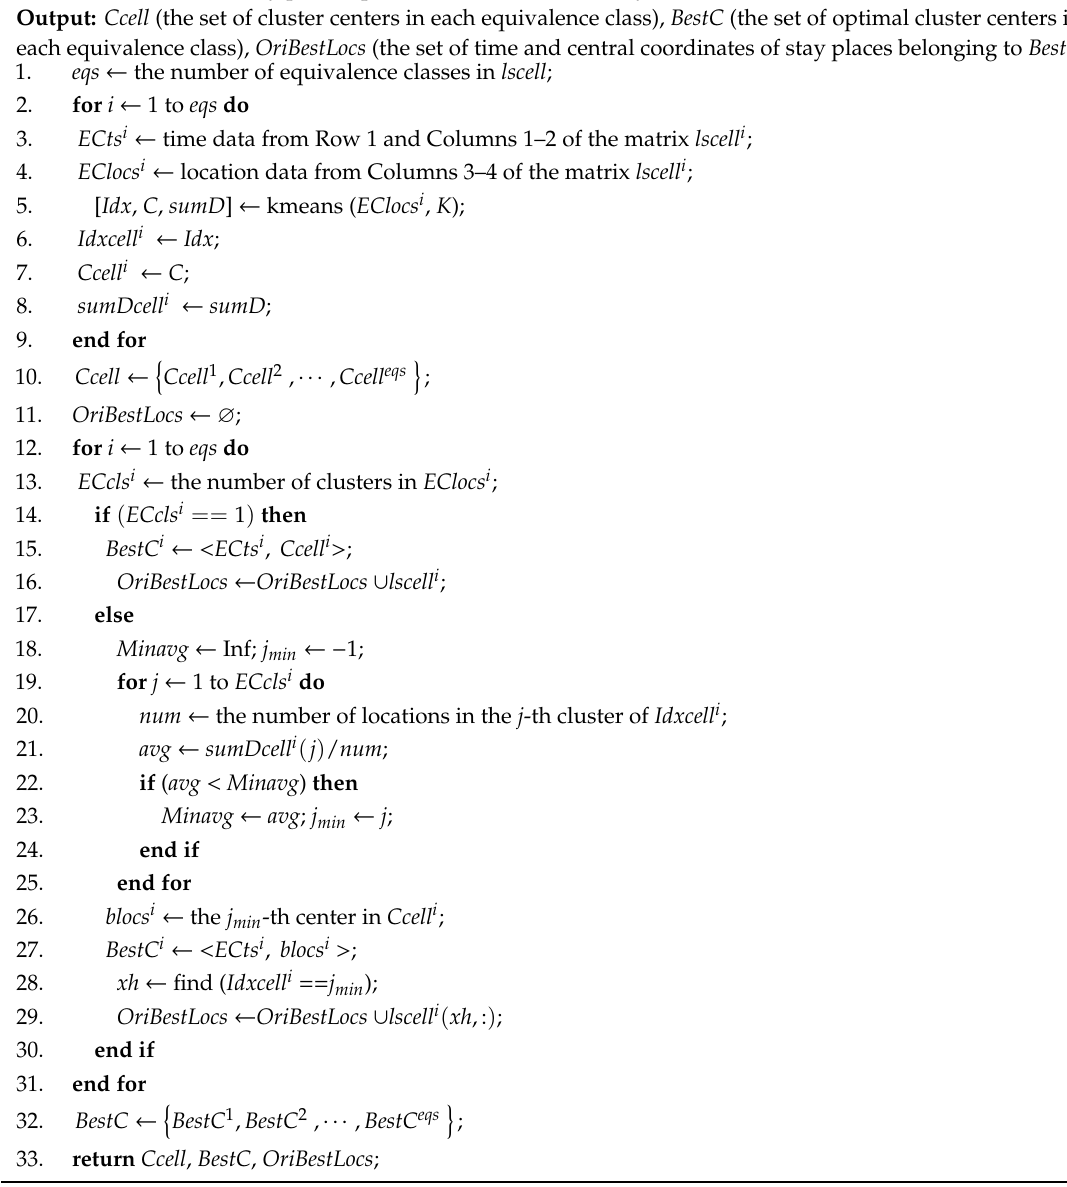
Algorithm 4. ClusterSP : Clustering Based on Stay